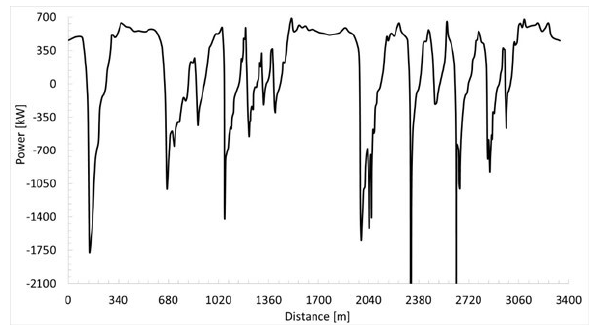
Fig. 5: Propulsive and braking